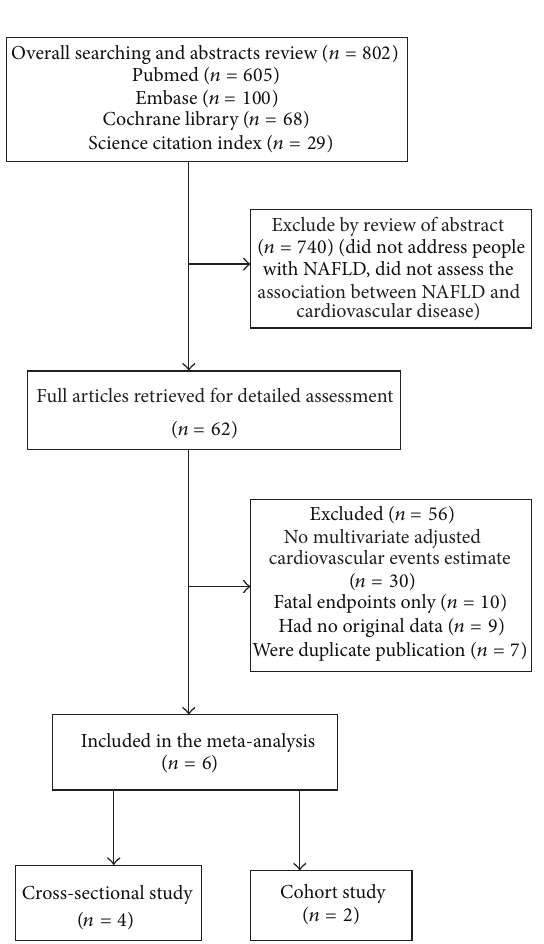
Figure 1: Flow diagram of studies assessed and included.